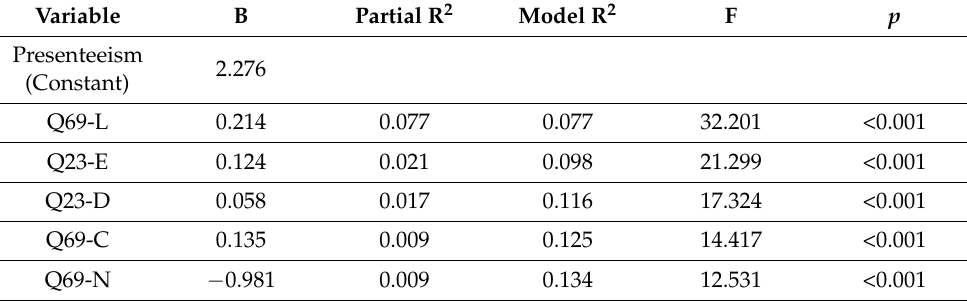
Table 3. Factors that affect presenteeism.